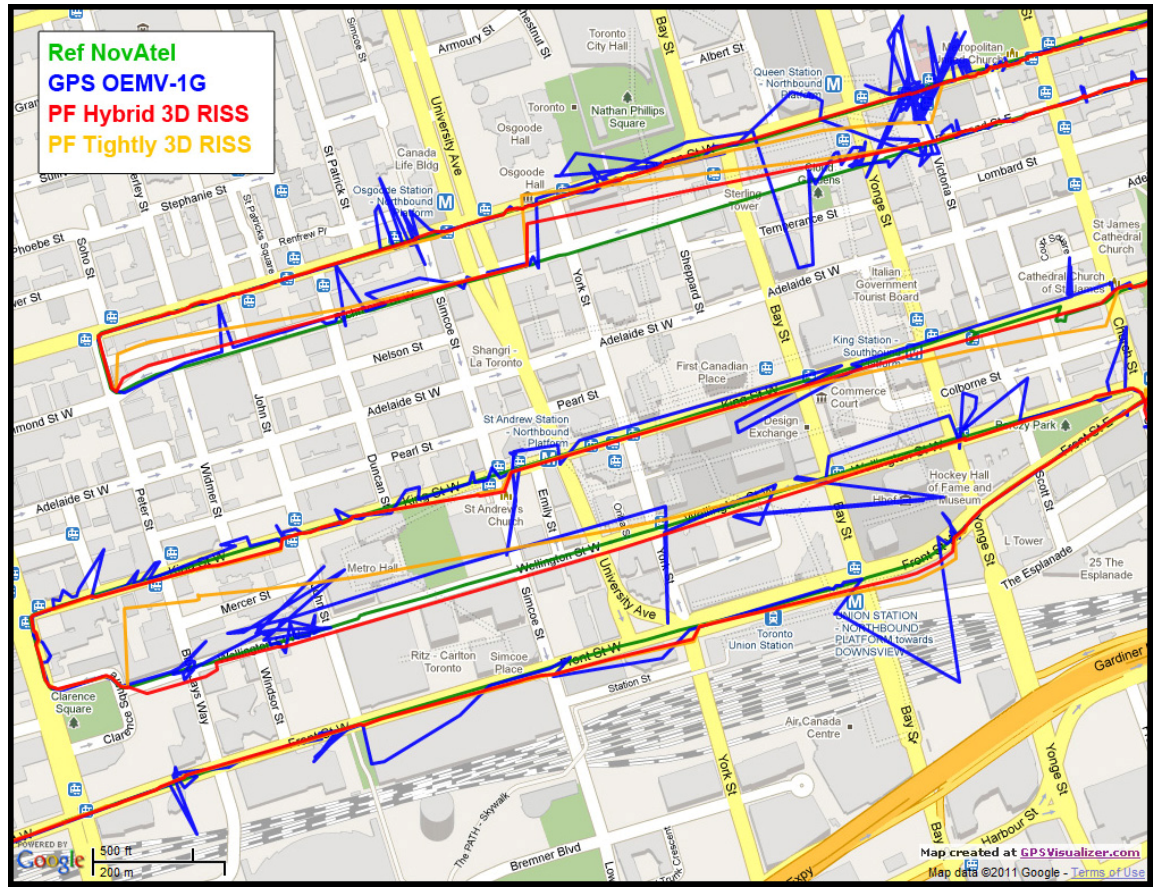
Figure 21. More detailed view on the downtown portion of Toronto trajectory showing the degraded GPS performance and the performance of the proposed navigation solution.